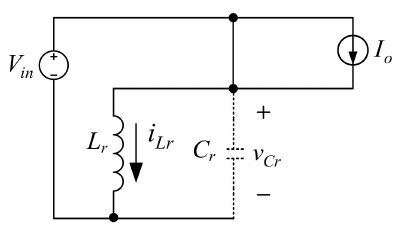
Figure 3. Equivalent circuit in state 1.